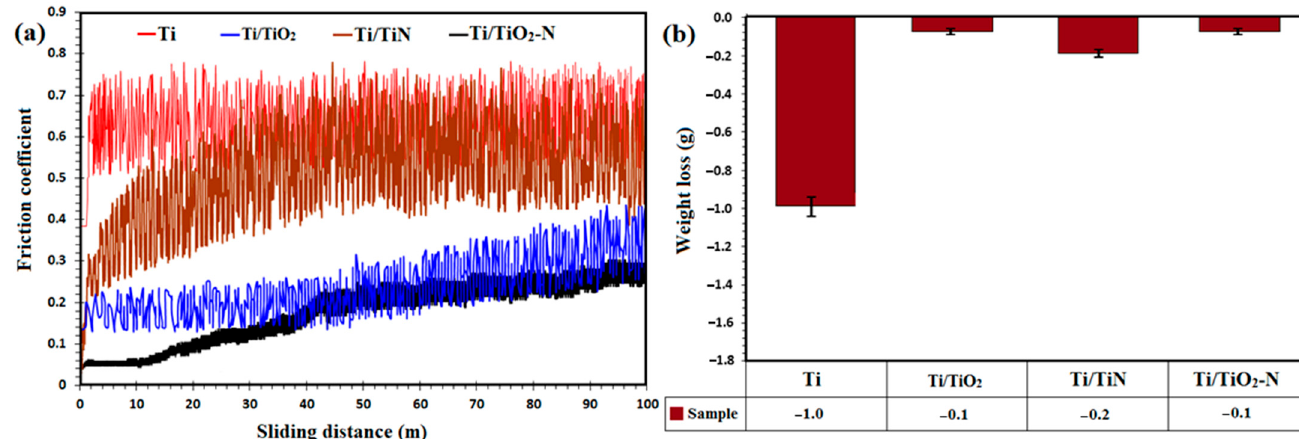
Figure 5. ( a ) The diagrams for friction coefficient changes versus slide distance and ( b ) weight loss for uncoated Ti alloy and Ti/TiO 2 , Ti/TiN, and Ti/TiO 2 -N coated samples.